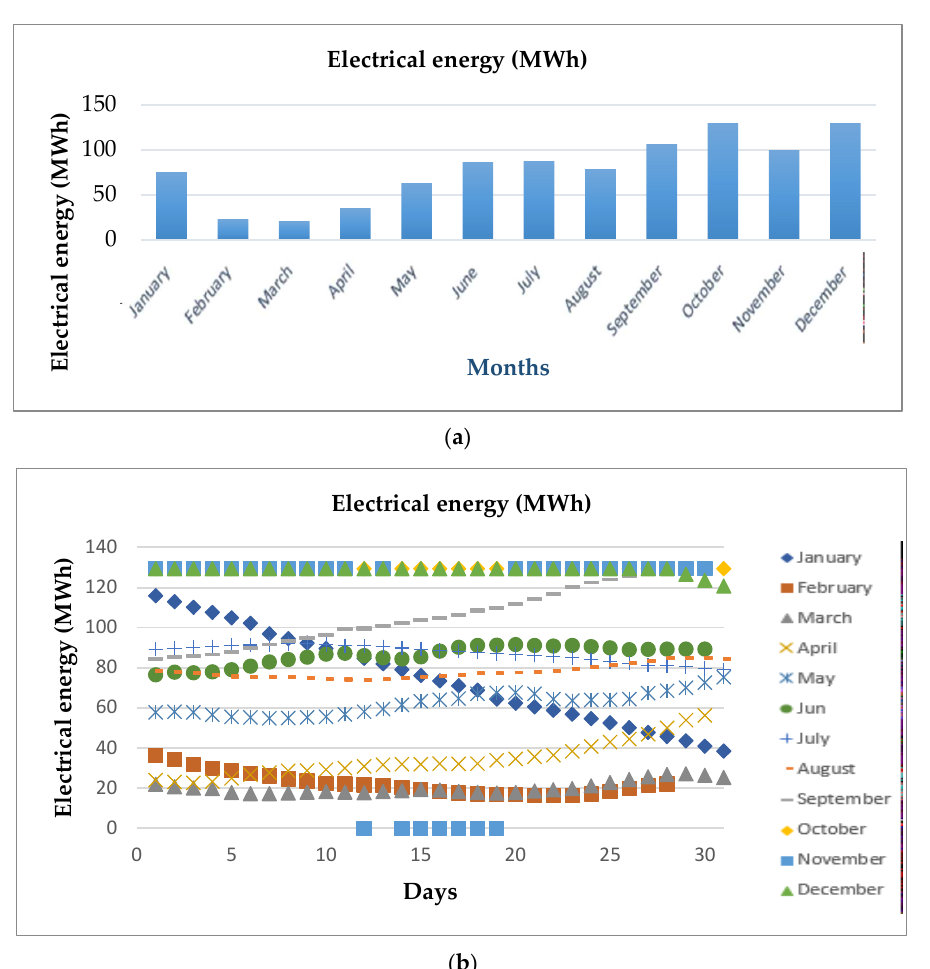
Figure 11. ( a ) Average monthly electrical power histogram and ( b ) average daily electrical power curve.